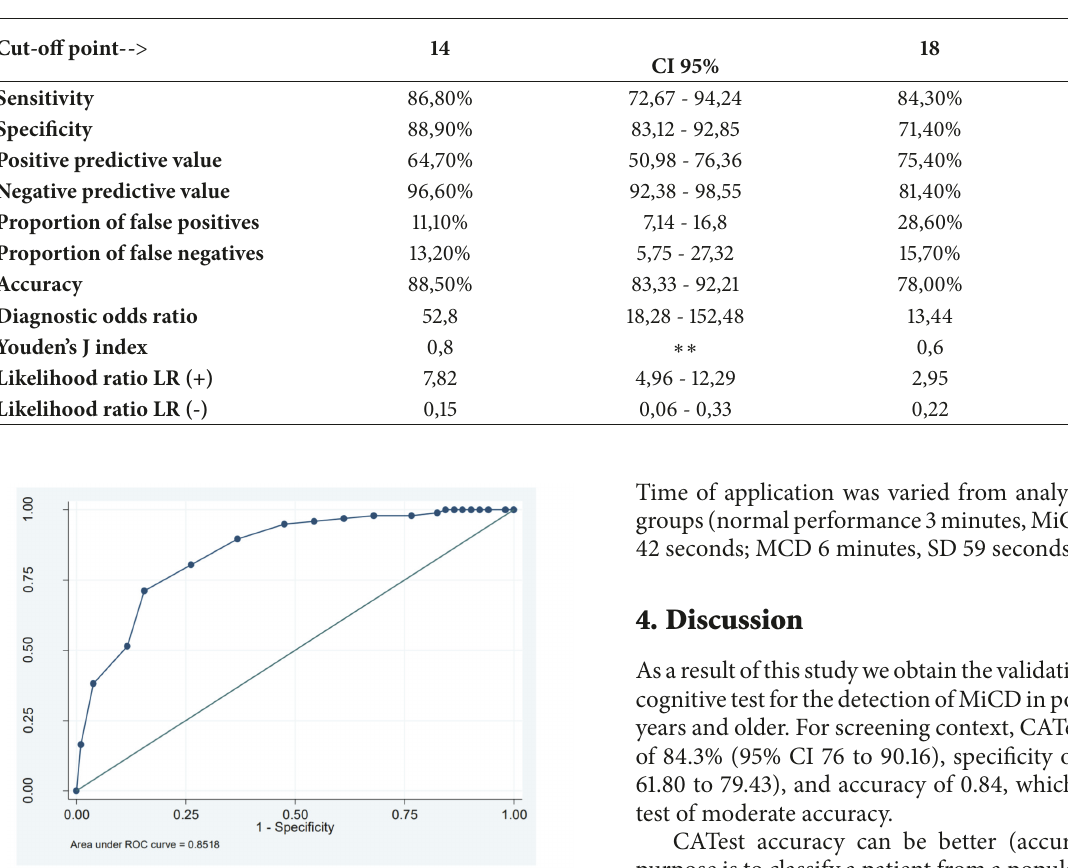
Table 3: CATest performance at cut-off point.